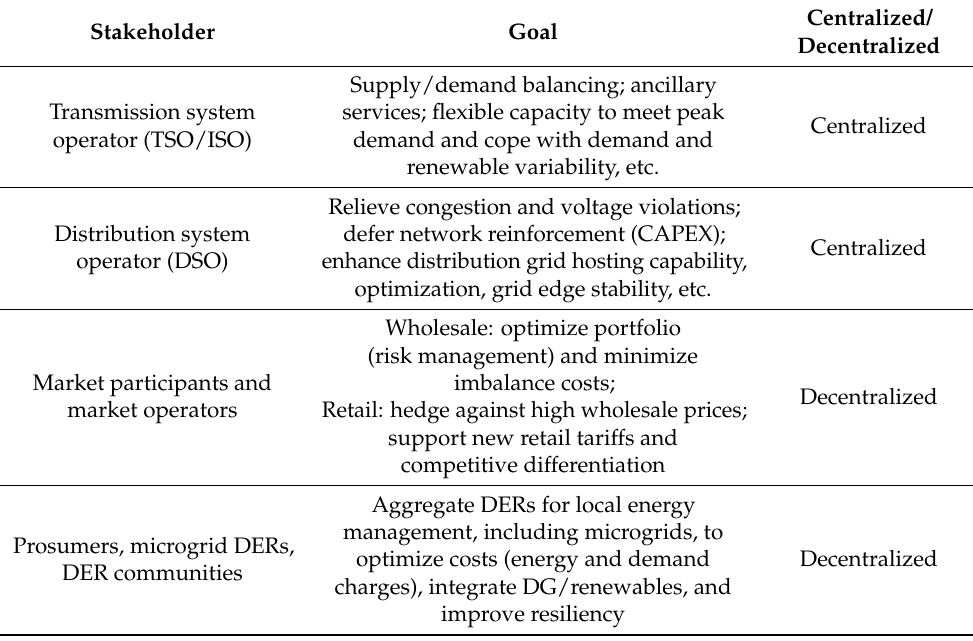
Table 1. Different DER management solutions and their